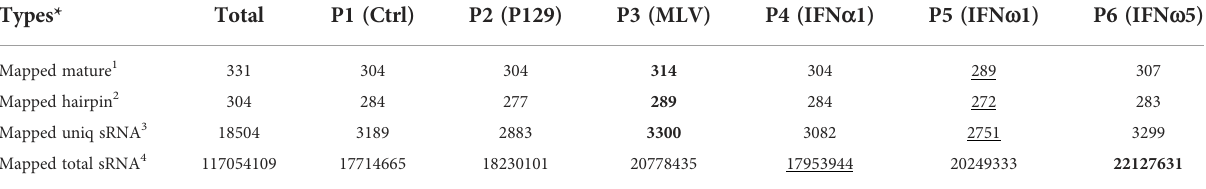
TABLE 3 Summary of known sRNA mapped in each sample.